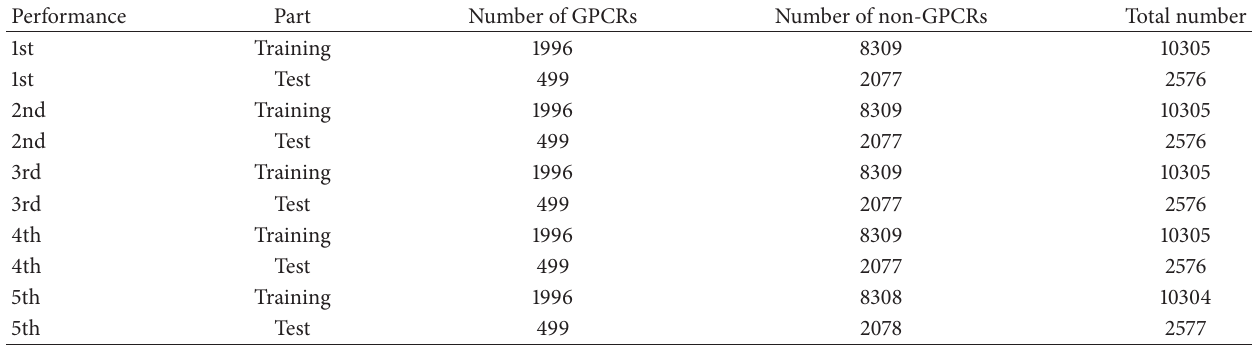
Table 3: The distribution of positive and negative sample numbers for training and test dataset.